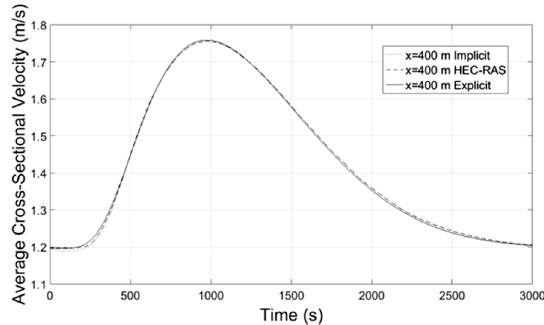
Figure 19. Discharge-Time at x = 400 m.